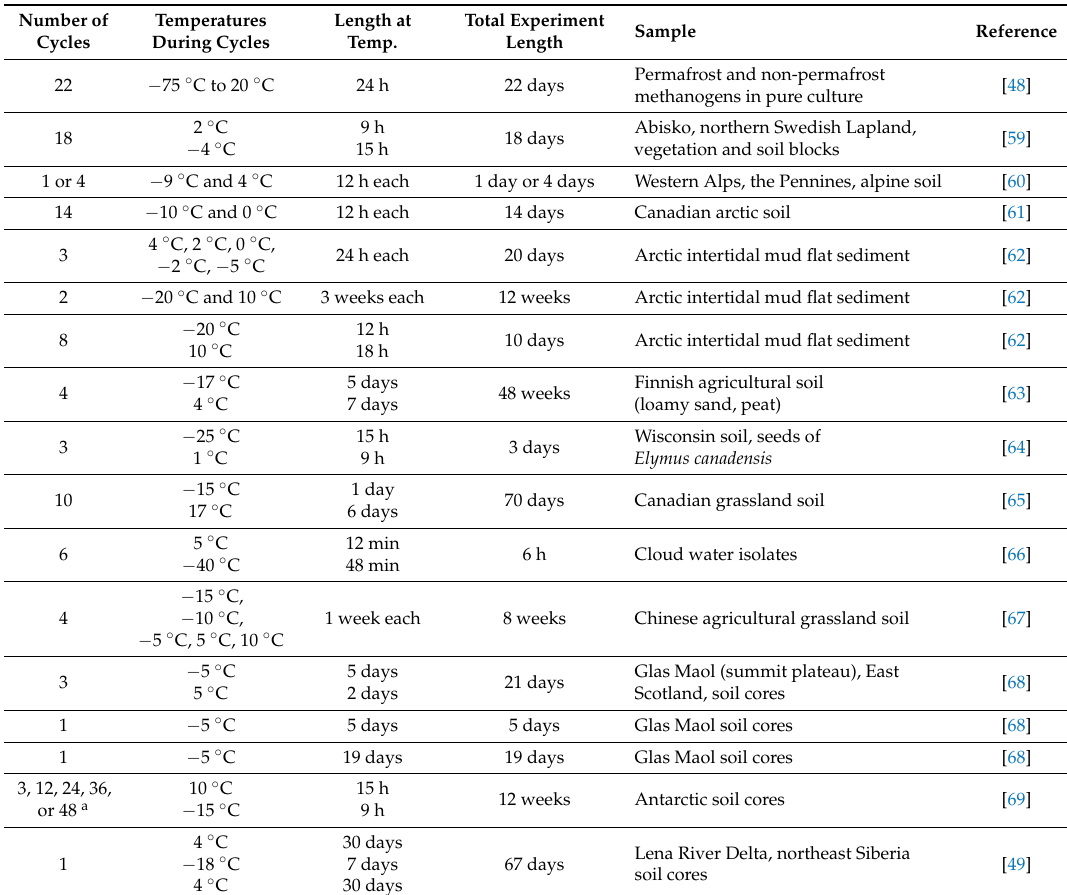
Table 1. Examples of previous freeze/thaw